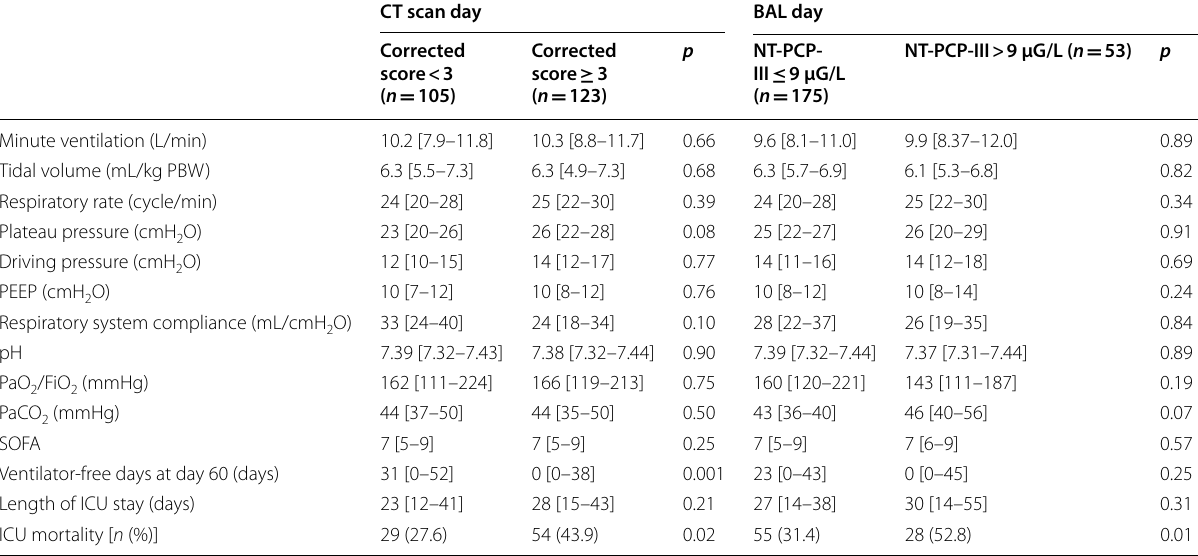
Table 3 Characteristics of ARDS, ventilatory parameters and outcome according to lung fibroproliferation and CT scan fibrosis score